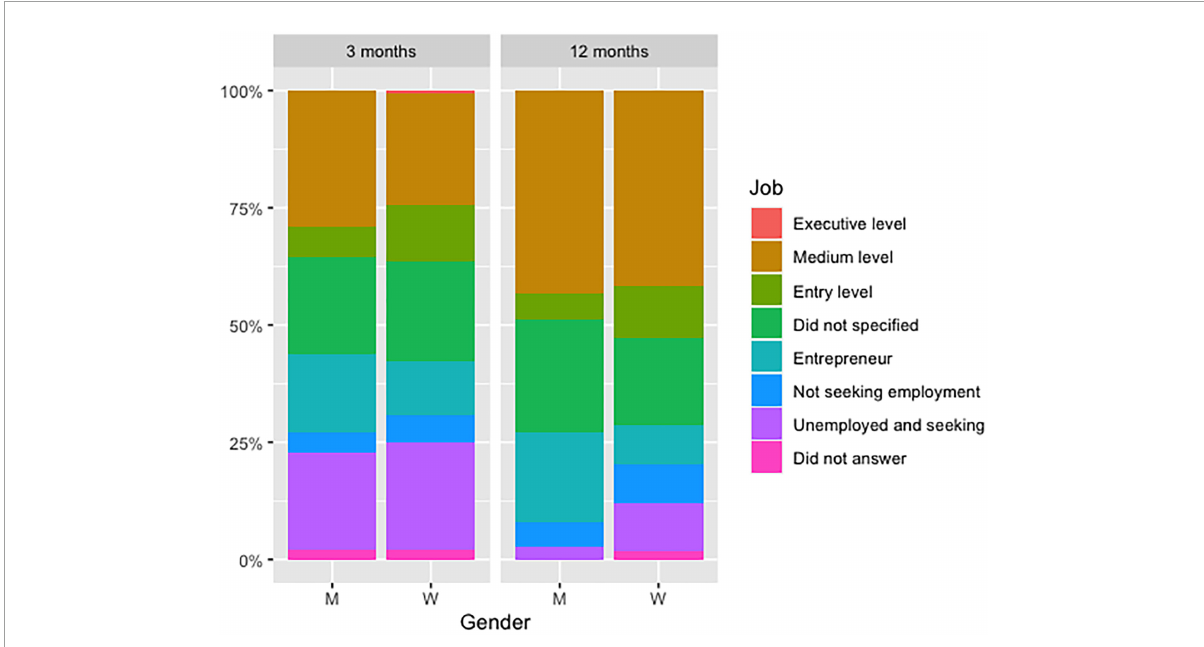
FIGURE10 Employment distribution after 3 and 12 months of graduation for all participants (M, Men; W, Women).